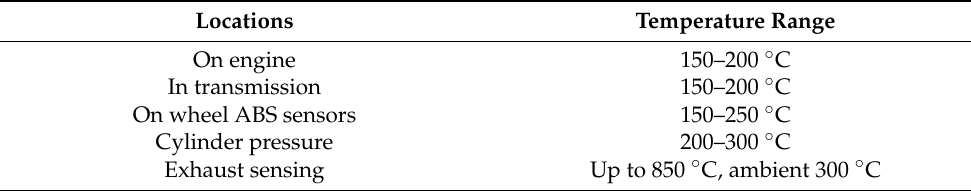
Figure 1. Schematic diagram of an HEV [1]. Table 1. Maximum temperature ranges of automotive with engine